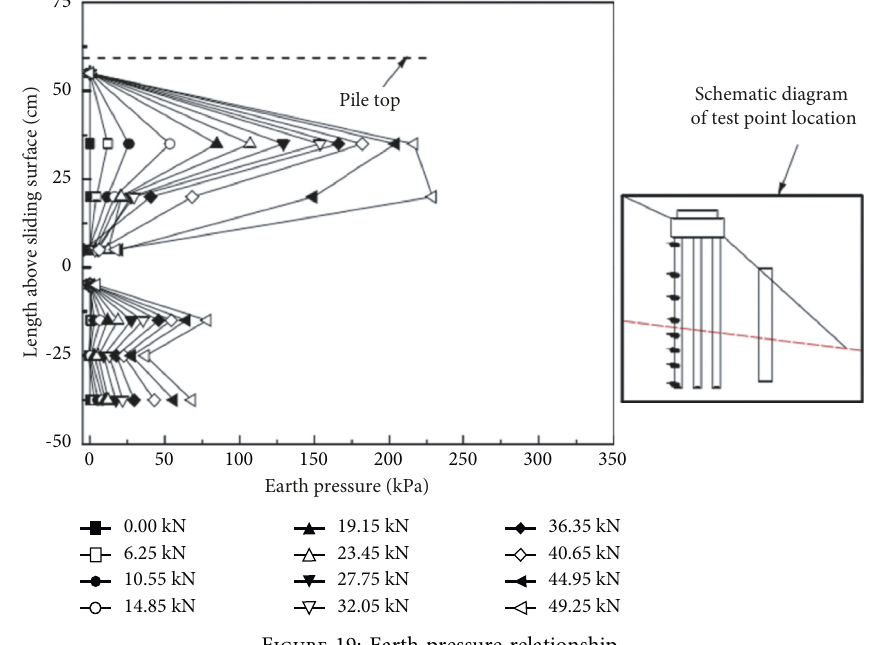
Figure 19: Earth pressure relationship.